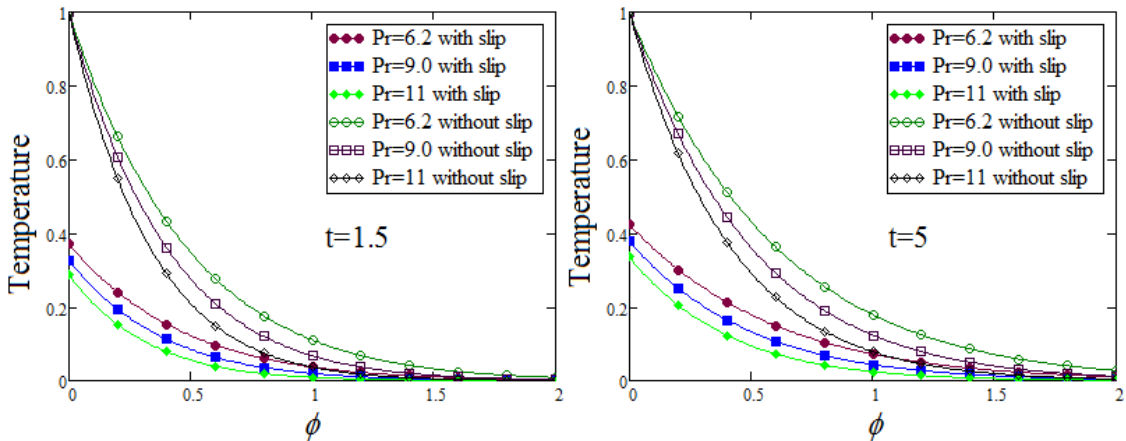
Figure 5. Graphical representations of temperature profile in the presence of slip and no slip condi- tions by taking the distinct values of Pr at two different levels of time, when α = 0.4, β = 0.3, ℘ = 0.4, ω = 0.5, and γ = 0.5.